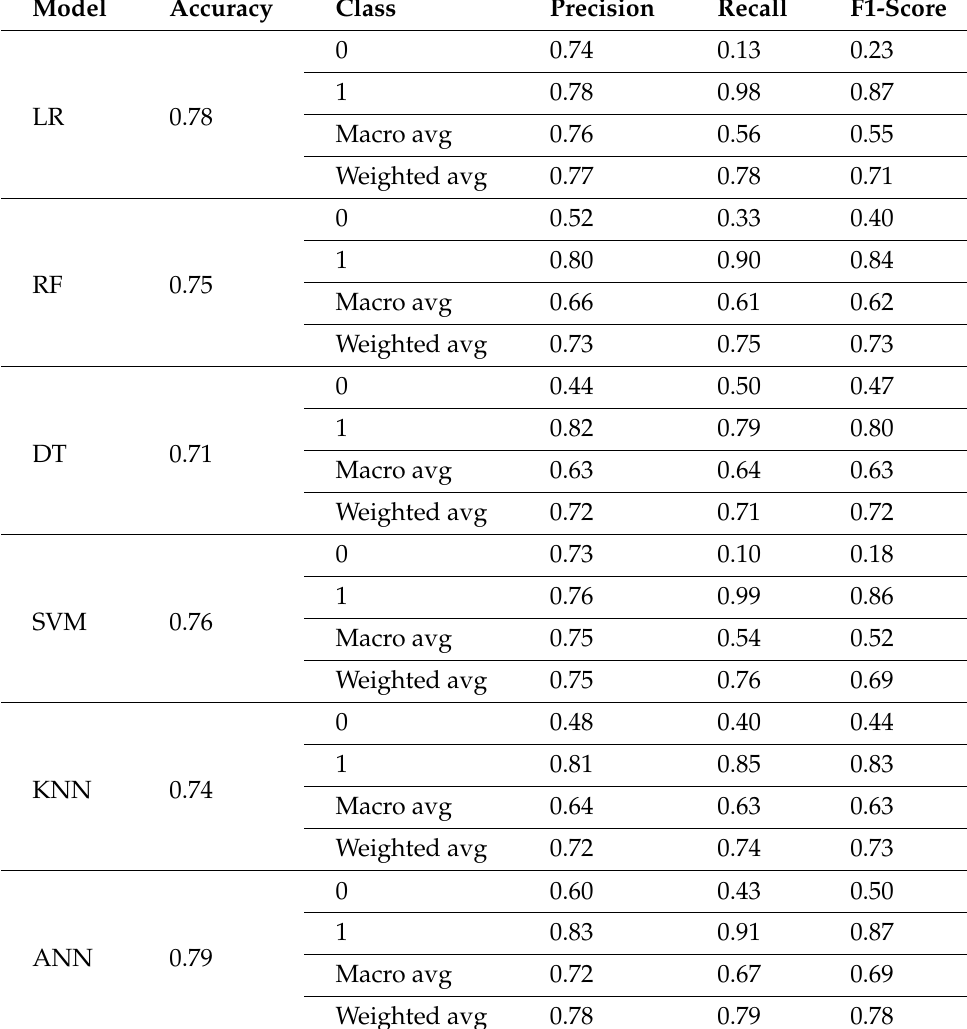
Table 6. The results of different classification algorithms trained in this work.